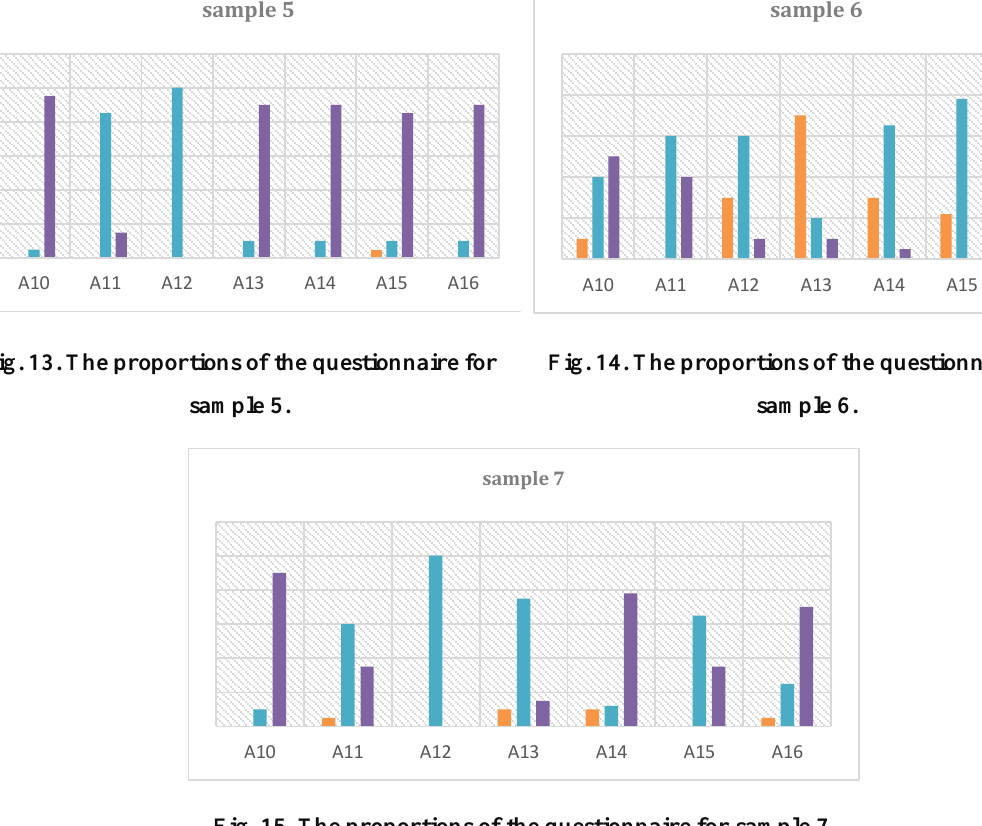
Fig. 15. The proportions of the questionnaire for sample